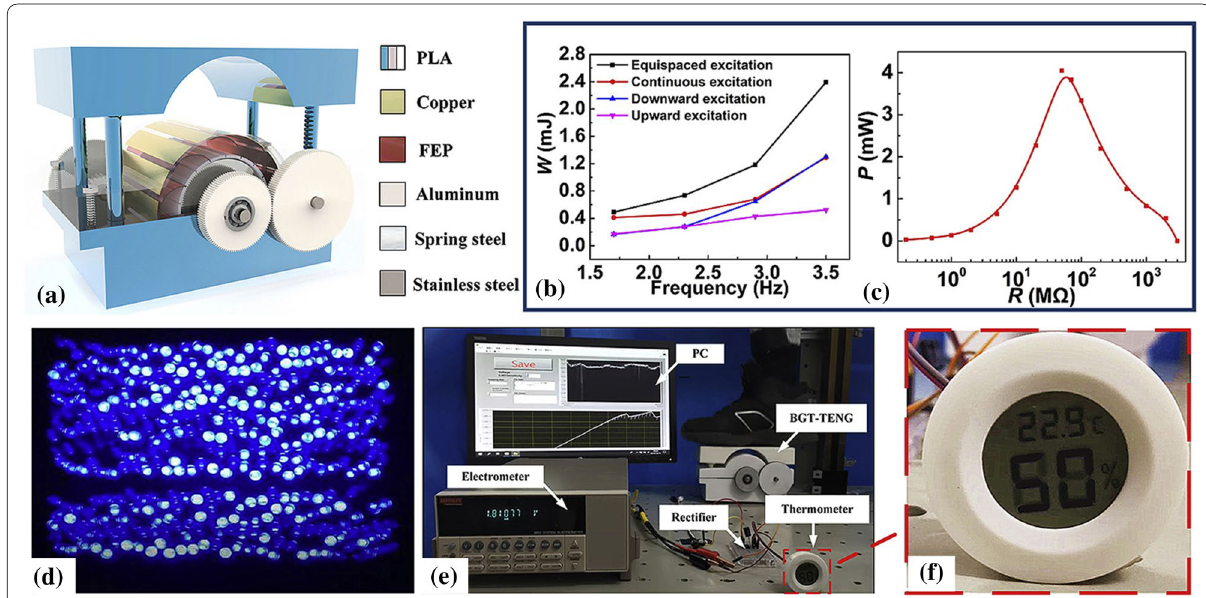
Fig. 9 a 3D printing assisted bi-directional gear transmission TENG b output energy c instantaneous power output with varying external resistances d powering 375 LEDs e experimental setup f output power of the TENG used to run a thermometer [31] (Images are re-used with the permission of the